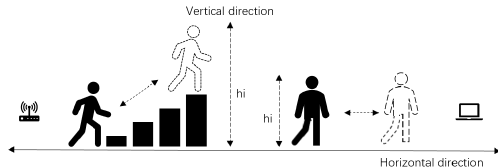
Figure 2. Different motion detection scenarios in the two